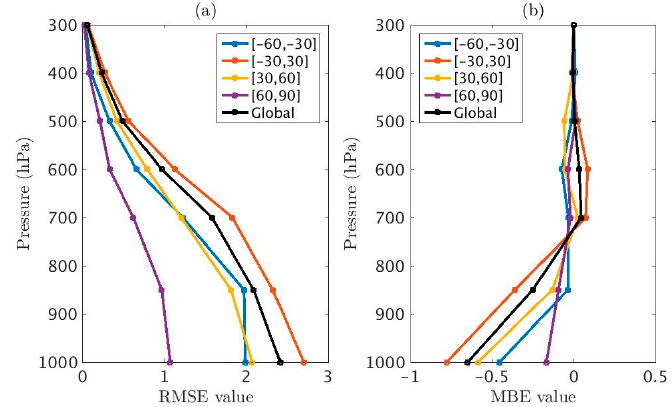
Figure 8. HIRS derived specific humidity (g/kg) compared to 2013–2014 radiosonde observations for global and latitude bands for ( a ) RMSE and ( b ) MBE (HIRS values minus radiosonde values). The RMSEs and MBEs shown above are based on retrievals from HIRS observation only.